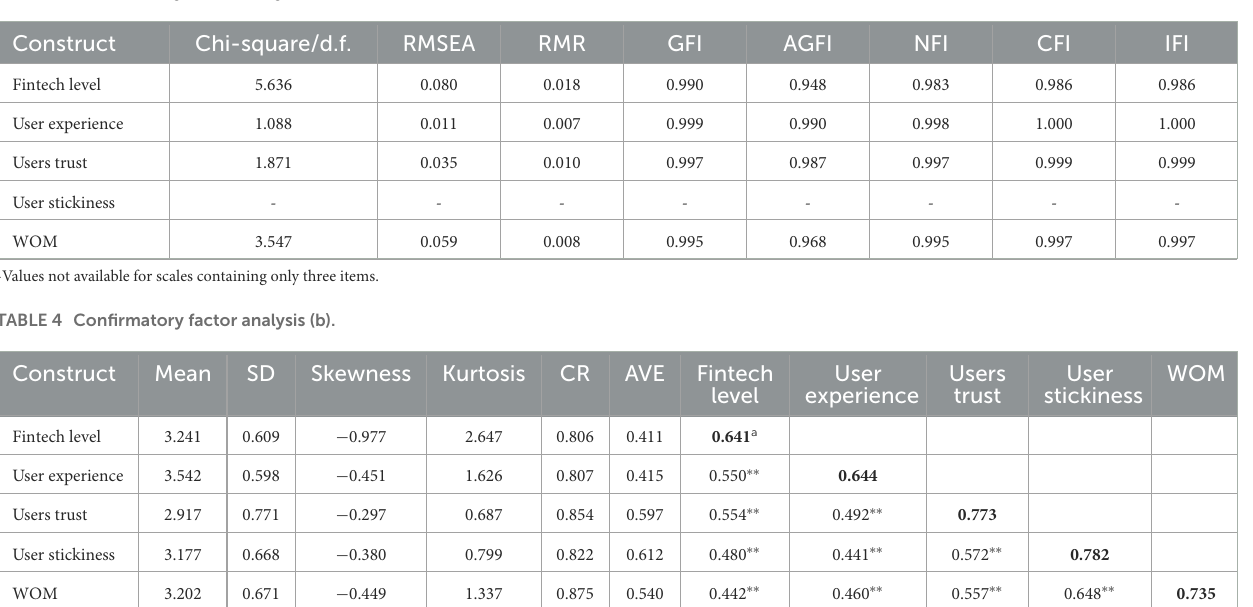
TABLE 3 Confirmatory factor analysis (a).